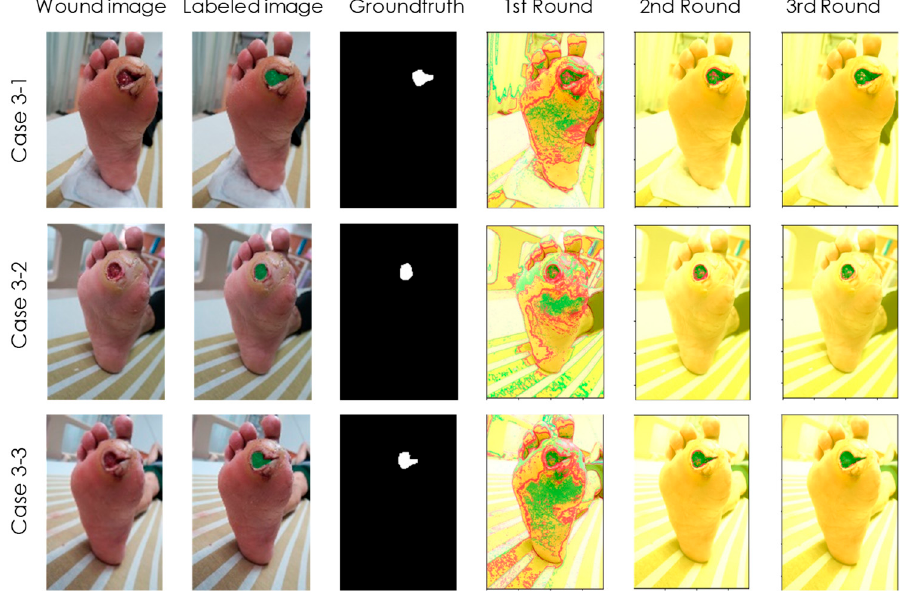
Figure 5. Case 3 of a 59-year-old female patient with a history of DM for over 15 years. Our detection model can accurately track the wound appearance on the surface but was unable to discover the putrescence occurring deeply behind the skin. Therefore, advance warning could not be given to prevent the occurrence of the toe amputation. Table 2. E xperimental results: the IOU rates compared to the